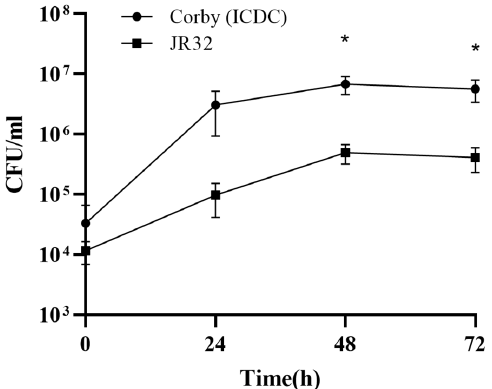
Figure 1. Comparison of intracellular proliferation in J774 mouse macrophages between Legionella pneumophila strain Corby (ICDC) and the control strain L. pneumophila Philadelphia 1 (JR32) (*, p < 0.05; Student’s t